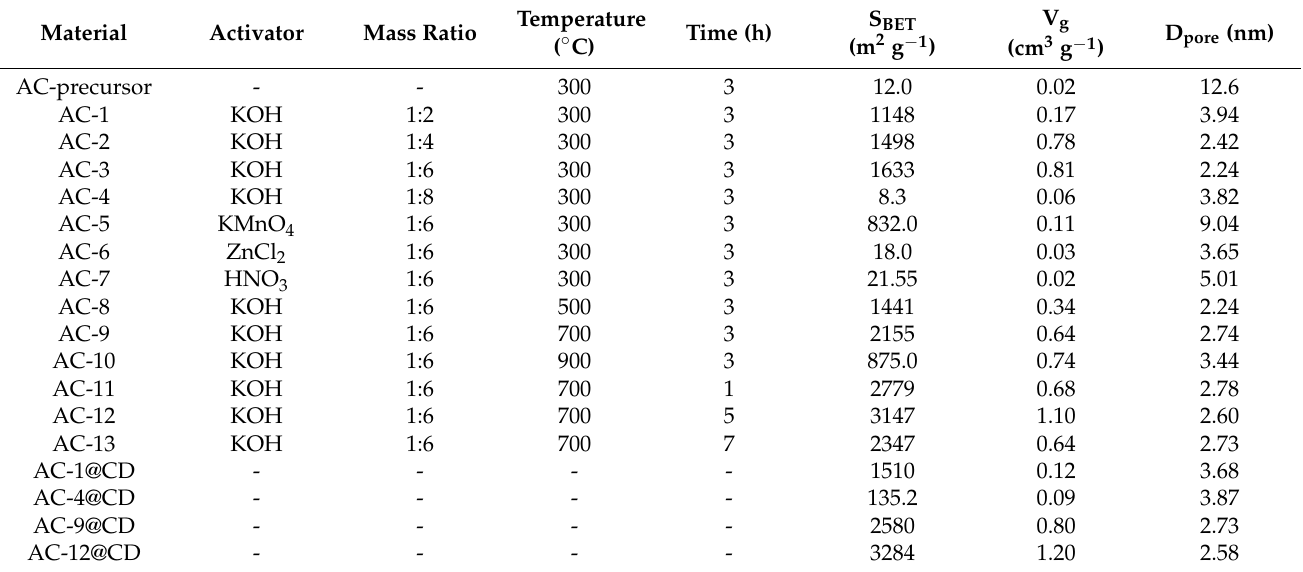
Table 1. Surface area and porosity property of AC fabricated with different conditions.